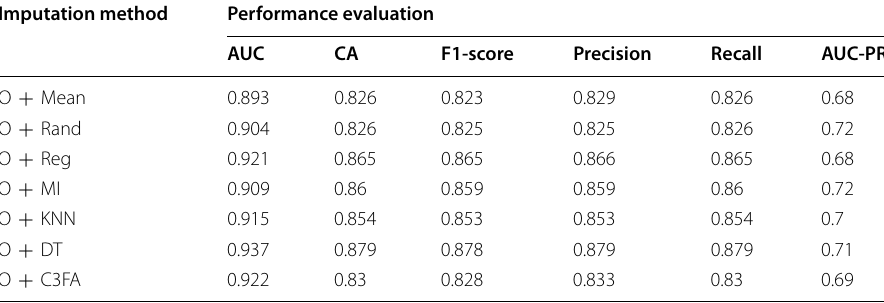
Table 4 Evaluation results using AUC, accuracy, F1-score, precision, recall, and AUC-PR for outlier removal’s +